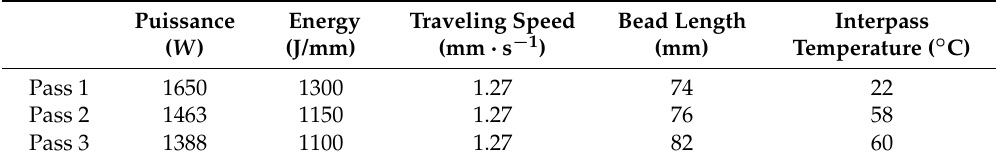
Figure 4. Diagram of the 3-pass slot weld sample. Table 1. Welding process parameters